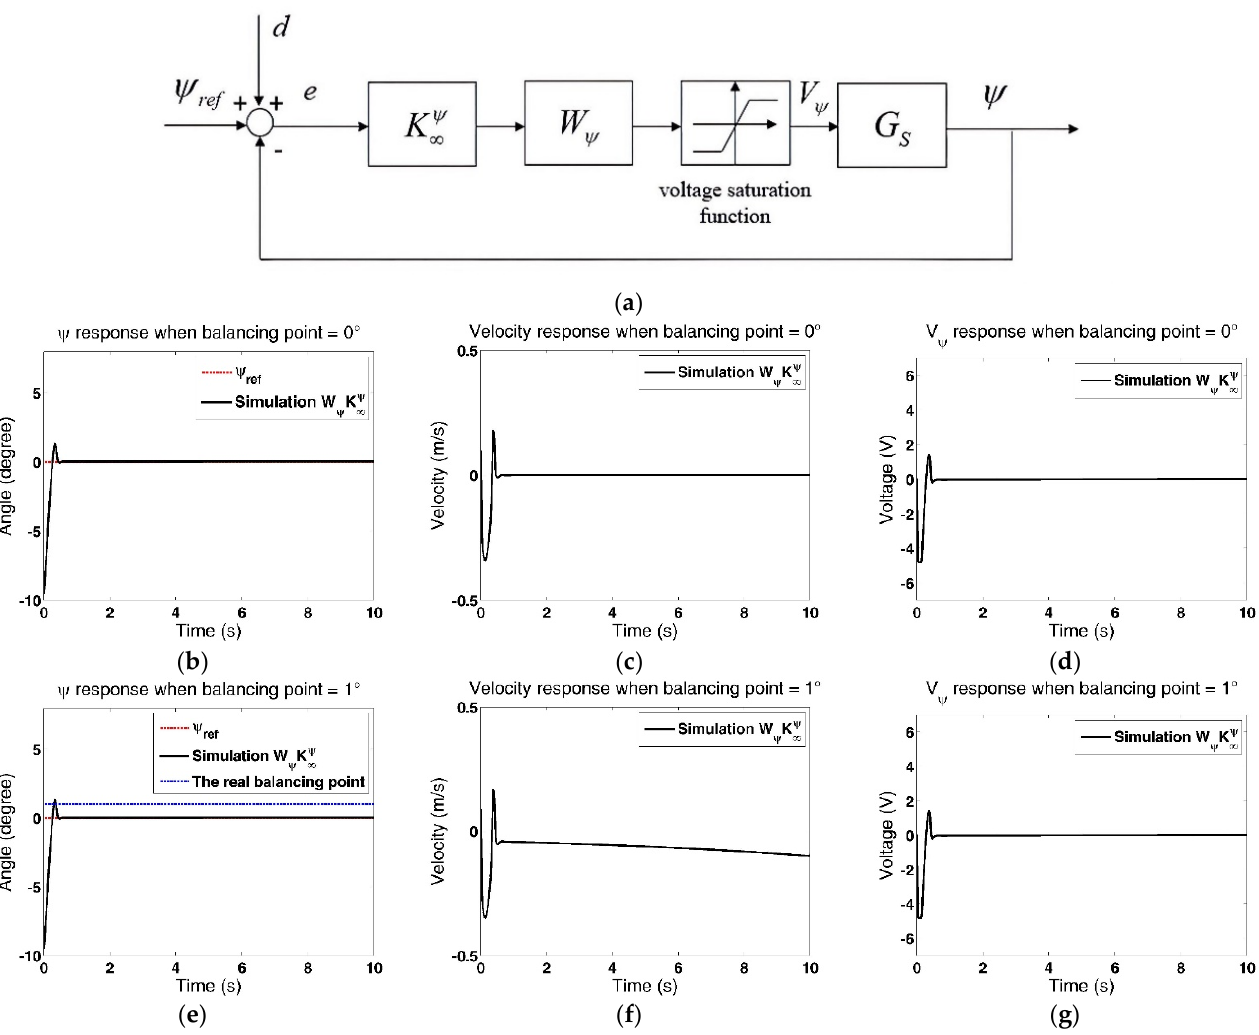
Figure 4. The balancing-loop control and system responses with ψ ref = 0 ◦ (simulations): ( a ) The balancing loop control structure; ( b ) ψ ( t ) response, balance point = 0 ◦ ; ( c ) Velocity response, balance point = 0 ◦ ; ( d ) control signal V ψ ( t ) , balance point = 0 ◦ ; ( e ) ψ ( t ) response, balance point = 1 ◦ ; ( f ) Velocity response, balance point = 1 ◦ ; ( g ) control signal V ψ ( t ) , balance point = 1 ◦.